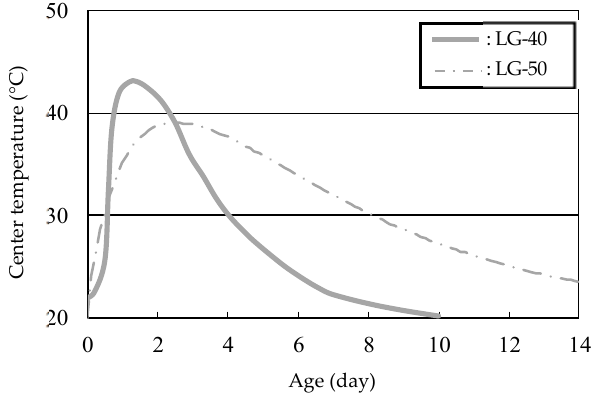
Figure 1. Temperature records in the center of block specimen.